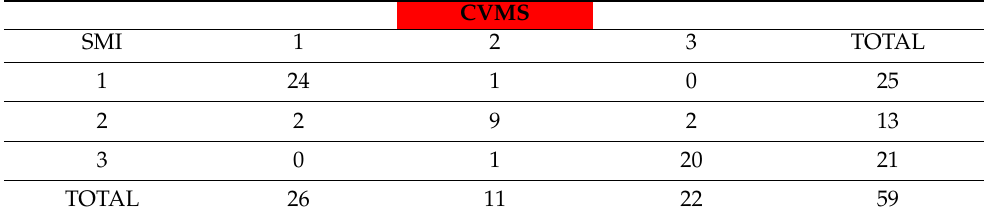
Figure 4. The distribution of the analyzed X-rays according to age groups within the group of males. Table 2. The result of the Cohen’s kappa coefficient for the group of females.